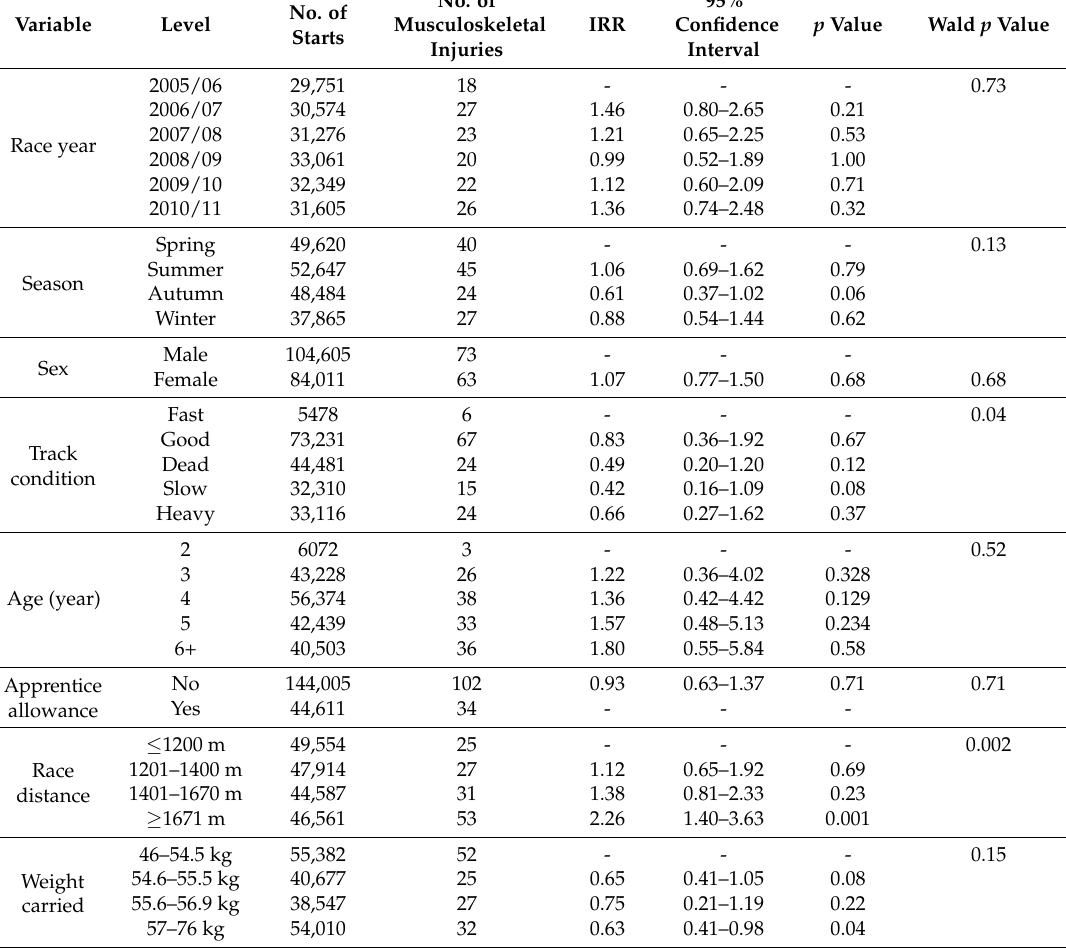
Table 2. Univariable Poisson regression for musculoskeletal injuries occurring during Thoroughbred flat races in New Zealand (2005–2011) ( n = 136) a